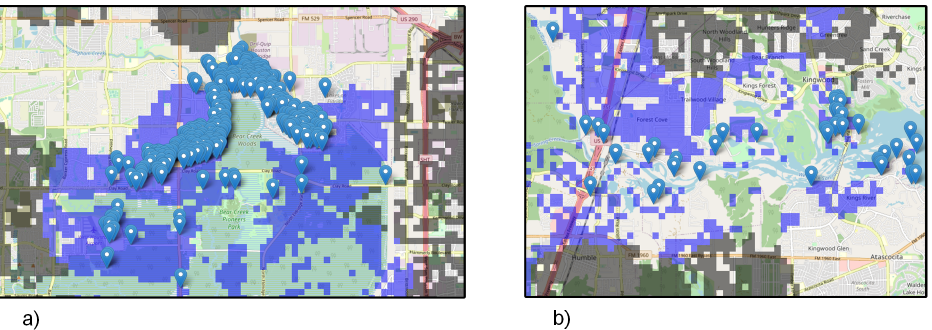
Figure 4. Qualitative comparison of raster cell predictions by our method (blue cells are flooded, grey non-flooded, obtained with polygon stacking, Tweet2Vec , x t and x F ) and coordinates of build- ings surrounded by floodwater extracted from a GeoEye-1 VHR imagery acquired on 31 August 2017 via crowdsourcing (marker glyphs). The areas shown are close to Addicks Reservoir ( a ) and Kingwood ( b ). The map tiles are by